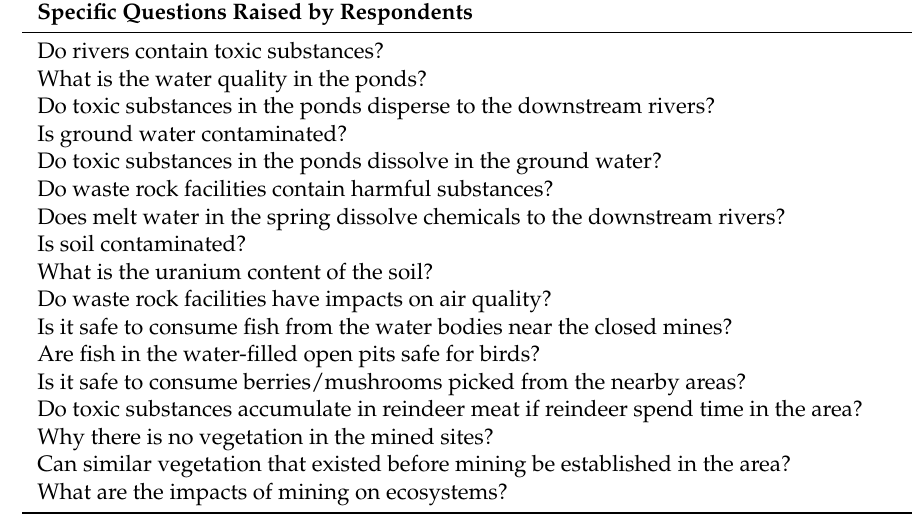
Table 7. Summary of specific questions raised by the respondents on the current state of the